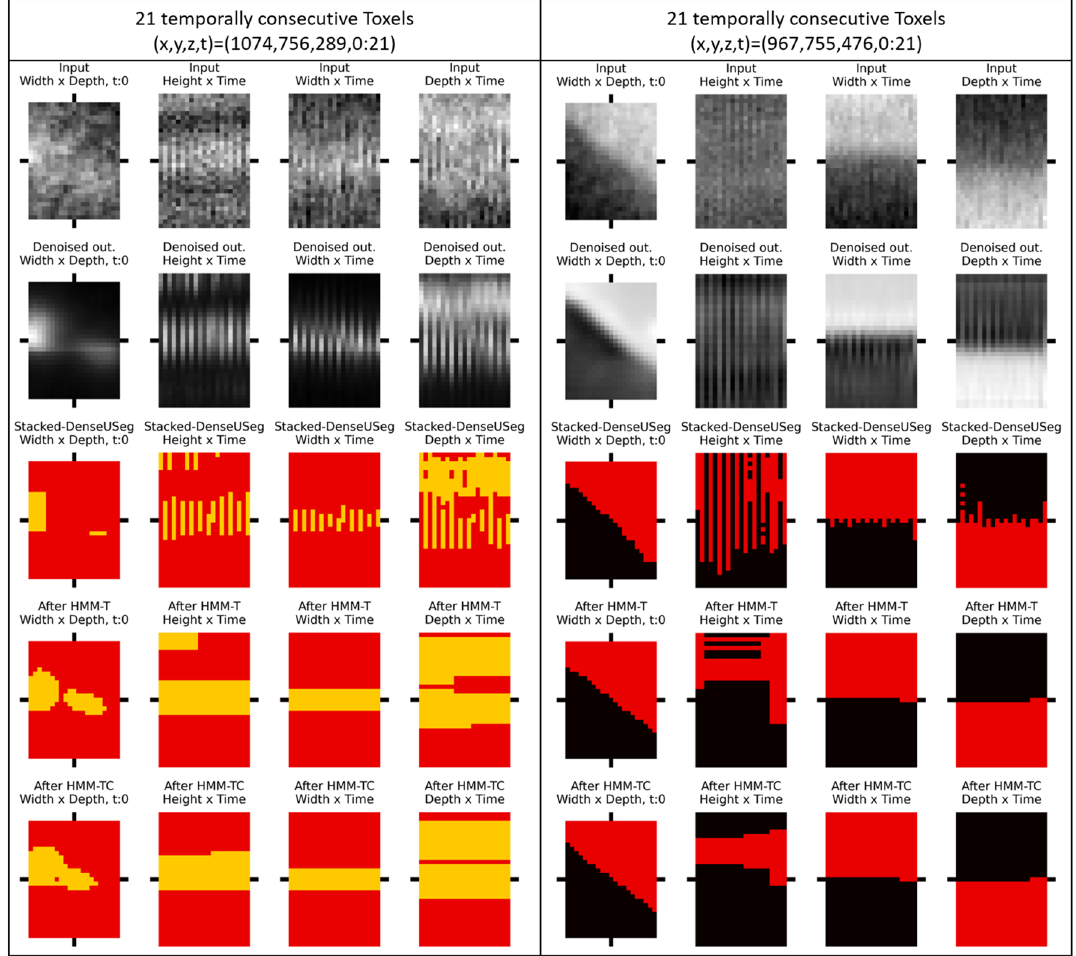
Figure 3. Comparison of segmentations of 2 groups of temporally consecutive toxels and their neighboring toxels (both spatially and temporally). The subfigures display predictions through the Width–Depth plane ( xz - plane ), Height–Time plane ( yt - plane ), Width–Time plane ( xt - plane ) and Depth–Time plane ( zt - plane ) respectively, after the use of Stacked-DenseUSeg ( 3rd row ), Stacked-DenseUSeg + HMM-T ( 4th row ) and Stacked-DenseUSeg + HMM-TC ( 5th row ). The black bars indicate that the toxels in question are the ones in the middle and the black crosshair point to the central toxel that belongs to first time-step ( t = 0 ). From the subfigures, it can be deduced that the HMM models solve temporal incoherence in the Stacked-DenseUSeg’s predictions. HMM-TC seems that it does not allow many transitions, potentially due to the utilization of Stacked-DenseUSeg’s prediction confidence in its emission